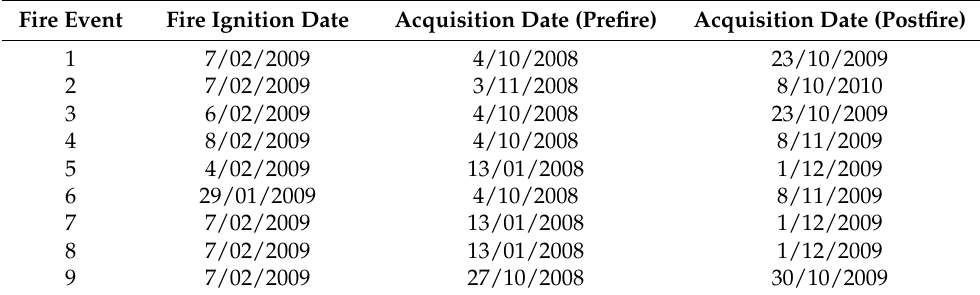
Table 2. Prefire and postfire Landsat 5 TM image tiles used for bushfire severity prediction of different fire events with different ignition dates under study.